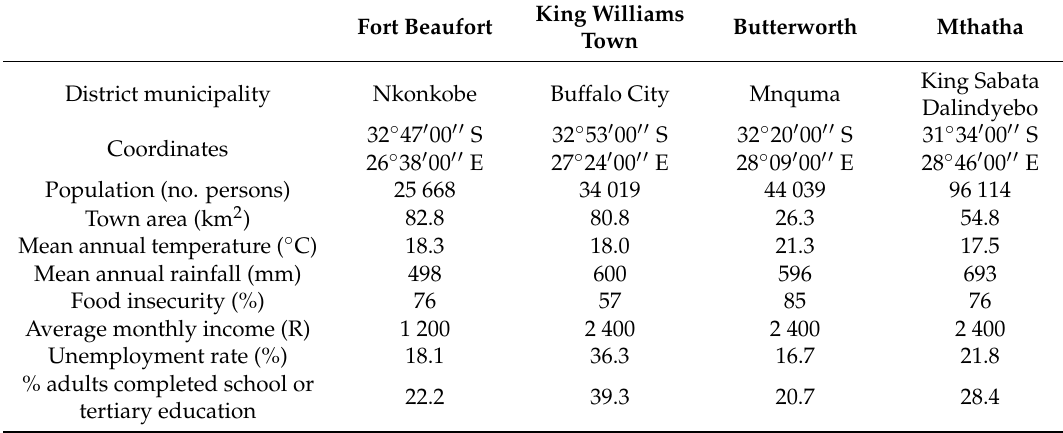
Figure 1. Location of study sites in the Eastern Cape. Table 1. Characteristics of the four study towns within their district municipality [31].